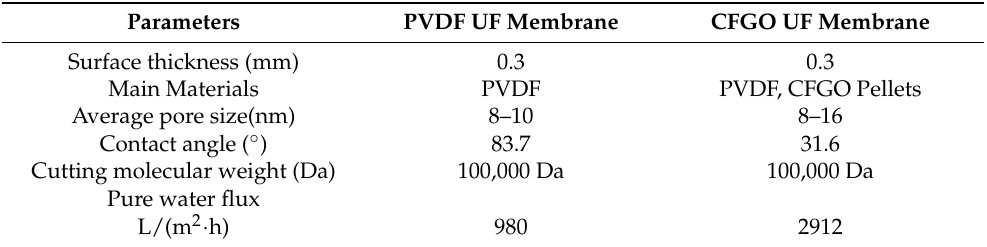
Table 5. The main index parameters of ultrafiltration